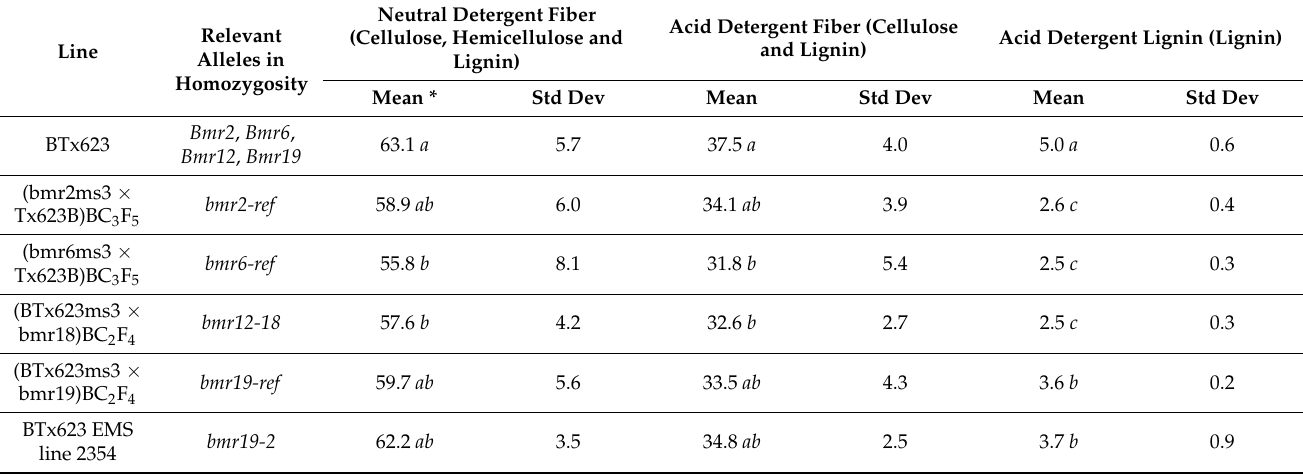
Table 3. Fiber analysis of greenhouse grown wildtype and bmr introgression lines in the BTx623 background. Relevant Line Alleles in